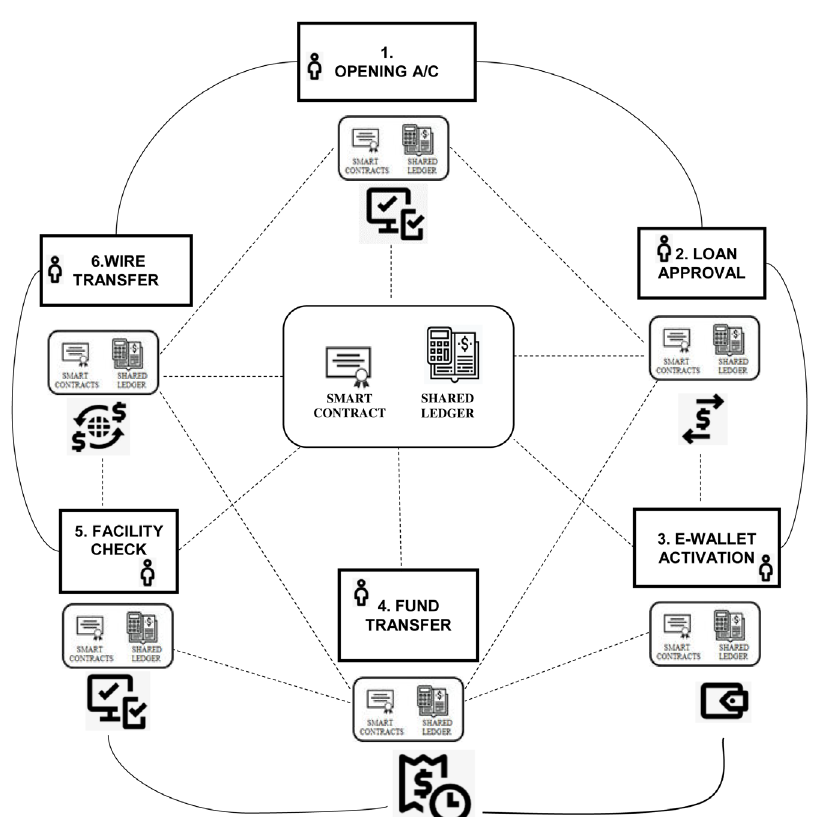
Figure 2. Shared Immutable Ledger (Muthaiyah,